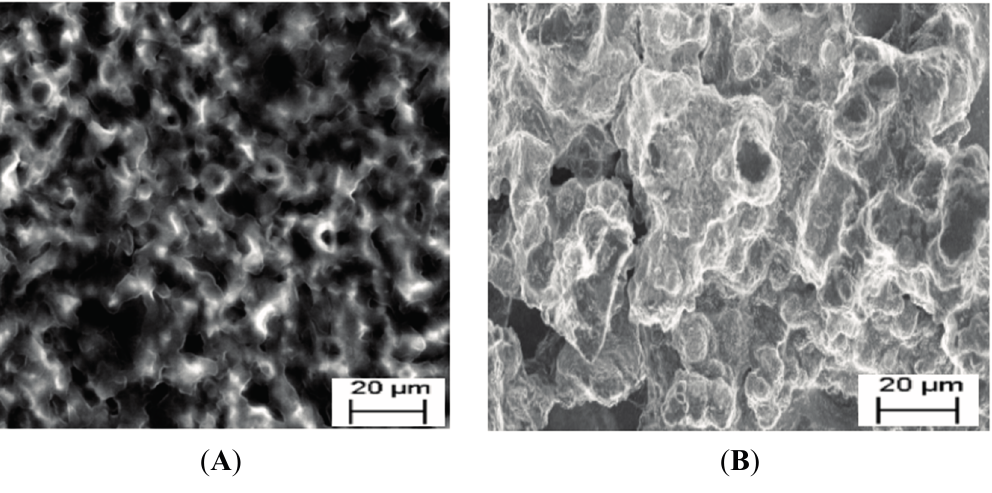
Figure 2. Scanning electron microscopic images of ( A ) G3PPT-co-P3HT; ( B )